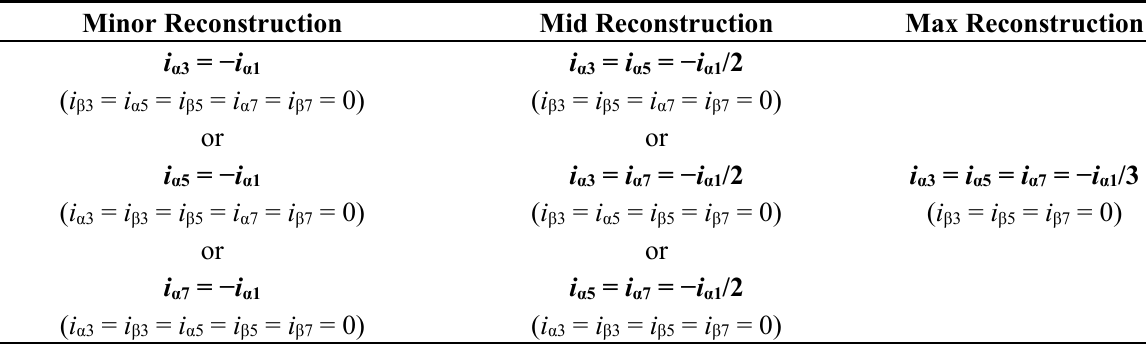
Table 2. Post-fault operation